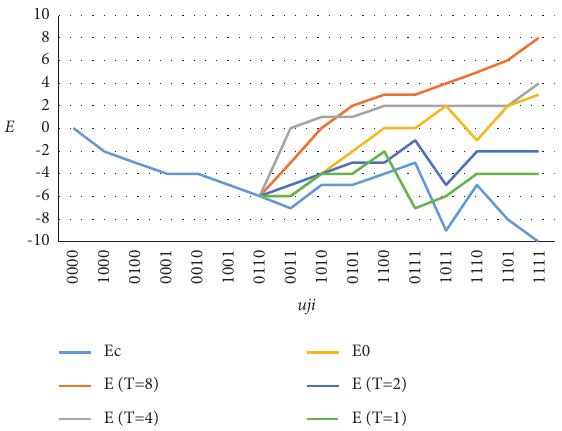
Figure 6: Change in the own component of the energy